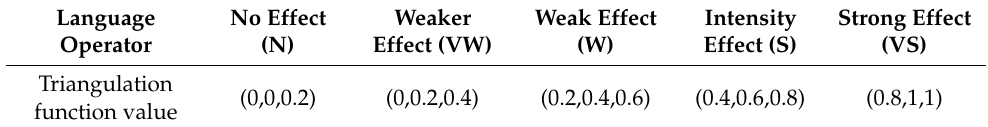
Table 2. The semantic transformation